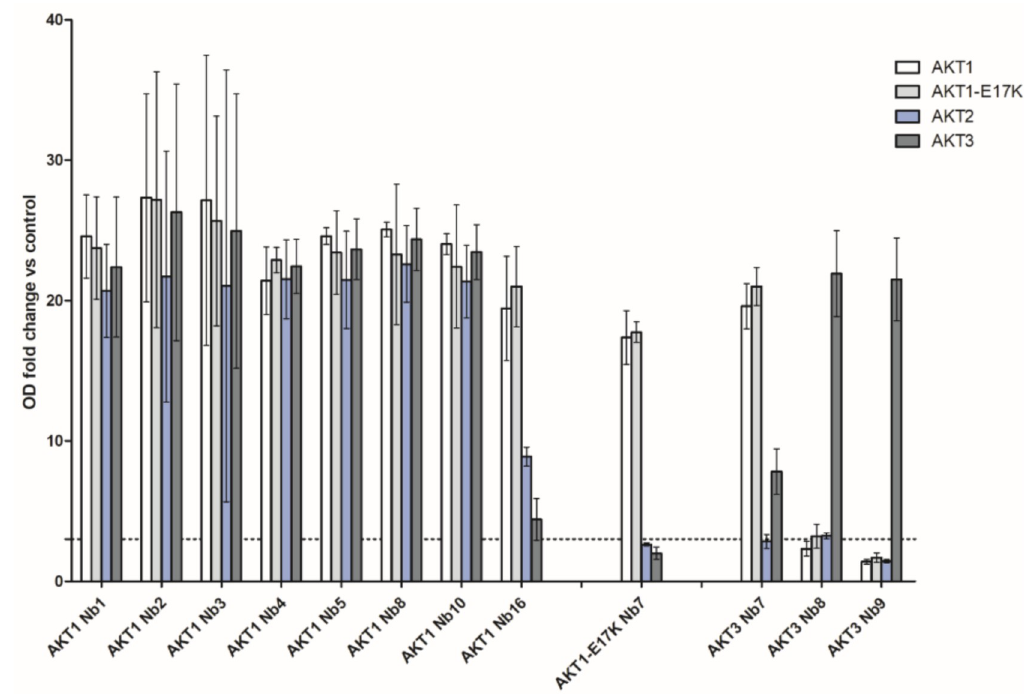
Fig 2. ELISA screening of AKT pleckstrin homology domain nanobodies. The mean and 95% confidence interval (CI) of OD 405 values are shown. Pleckstrin Homology domains were coated in wells of a 96 multiwell plate at 1 μ g/ml and incubated with the AKT Nbs (20 μ l from a crude periplasmatic extract). The EGFP Nb was used for background correction. A Nb was considered to interact with a PH domain when the OD 405 fold change (normalized to the OD 405 of the EGFP Nb for the same PH domain) was at least three (denoted by a dashed line). Nbs, which did not meet this criterion for any PH domain are not shown on this Figure and were not included in further analysis. ELISA data for the complete Nb sets are available in S2 Fig.